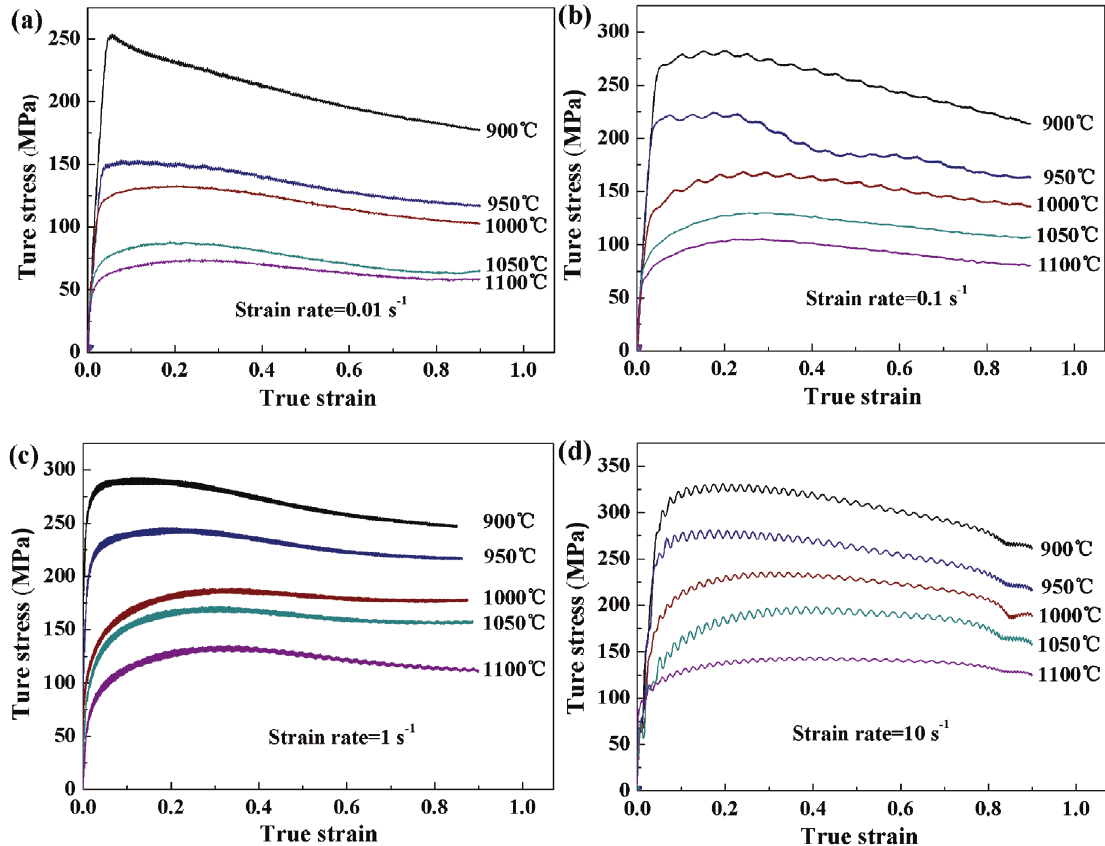
Fig. 1: True stress-true strain curves for FV520B steel during hot deformation of: (a) 0.01 s − 1 ; (b) 0.1 s − 1 ; (c) 1 s − 1 ; (d) 10 s − 1